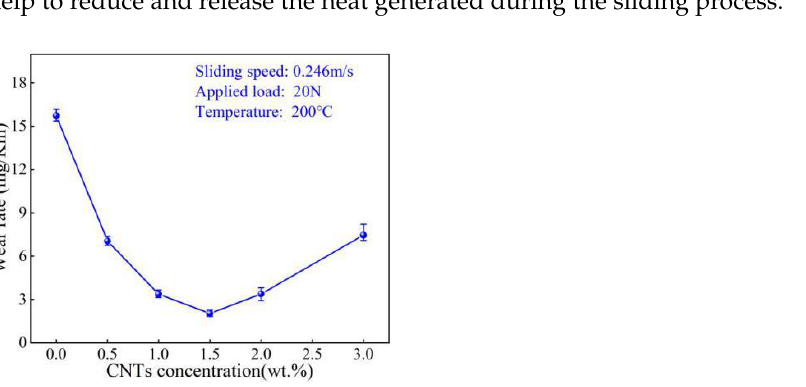
Figure 14. Wear rate of the x % CNTs /Al-Cu-Mg-Si composites under 200 °C.